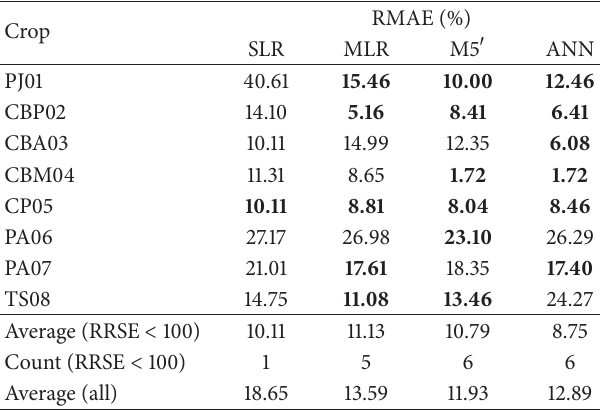
Table 9: RMAE (%) measures using the LAS on testing dataset. RMAE (%) Crop SLR MLR M5 󸀠